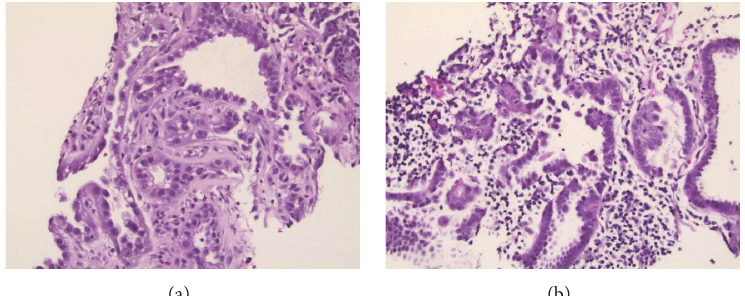
Figure 3: The abdominal wall mass (a) comprised small glands as well as large cystic spaces lined by cuboidal cells with eosinophilic, vacuolated or clear cytoplasm, and variably conspicuous nucleoli. The lymph node (b) showed glandular structures with morphology similar to that seen in the abdominal wall mass and residual lymphoid tissue in the background (hematoxylin-eosin staining, 200x).